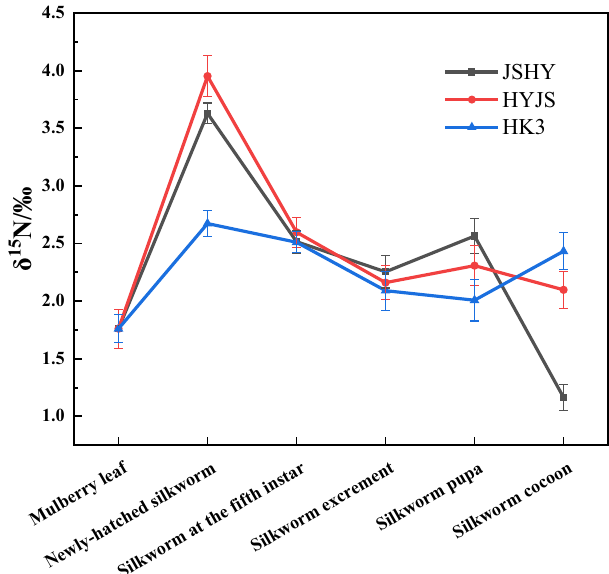
Figure 2. Line chart of nitrogen stable isotope ratios in